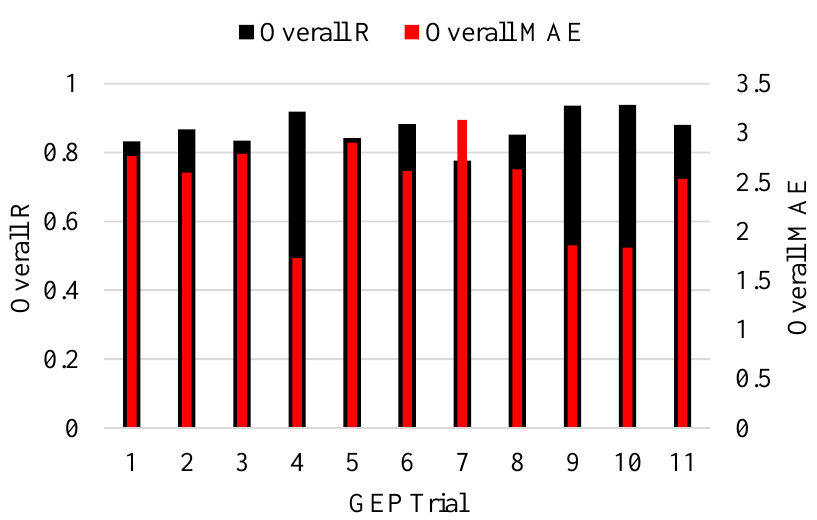
Figure 4. Comparison of the developed trials.